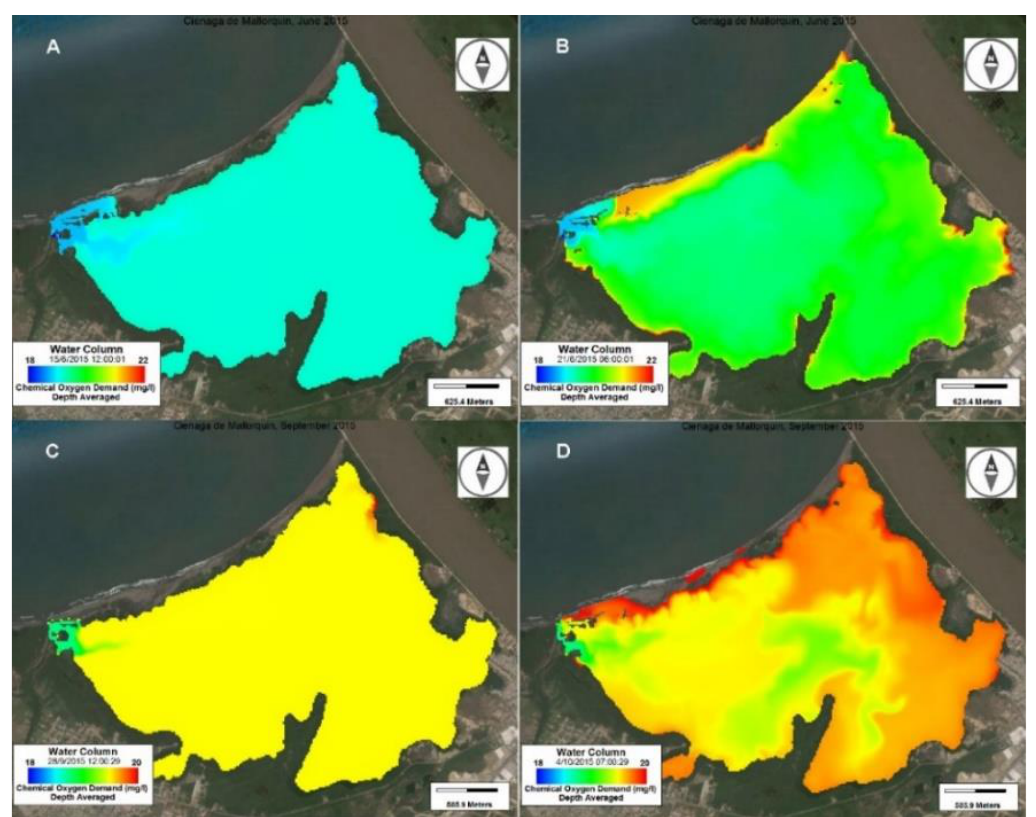
Fig. 7: Simulation of COD variation. A) Transition Period (0.5 days of simulation). B) Transition Period (6 days of simulation). C) Wet season (0.5 days of simulation). D) Wet season (6 days of simulation) (wet season: note the change in scale values)